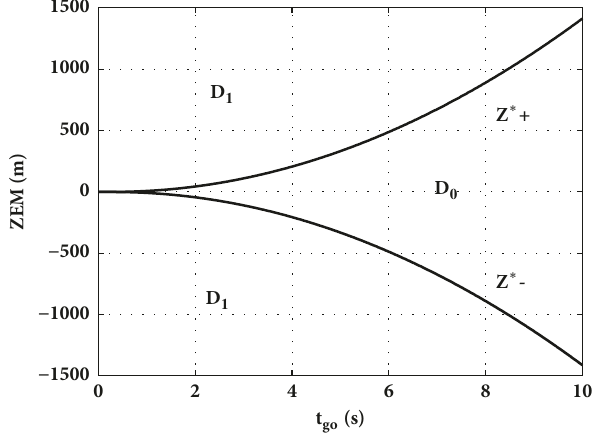
Figure 2: Game space: 𝜌 𝑀 > 𝜌 𝑇 , 𝜌 𝑀 𝜏 𝑇 > 𝜌 𝑇 𝜏 𝑀